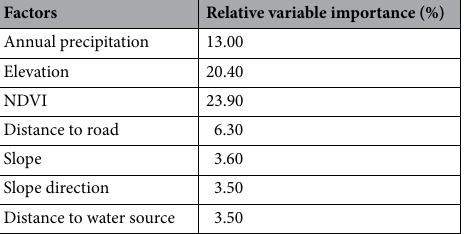
Table 3. Summary of relative variable importance of the selected factors.